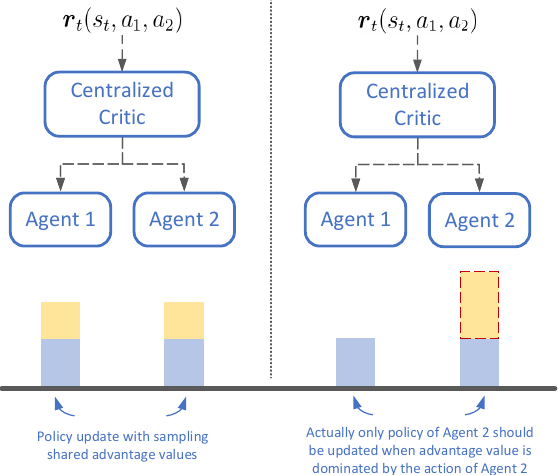
Figure 1. The schematic diagram of two agents with shared advantage function. The centralized critic would mislead the policy update to when we train the agents with finite samples as the left part of this figure, while it is correct by only updating the policy of Agent 2 as the right part.